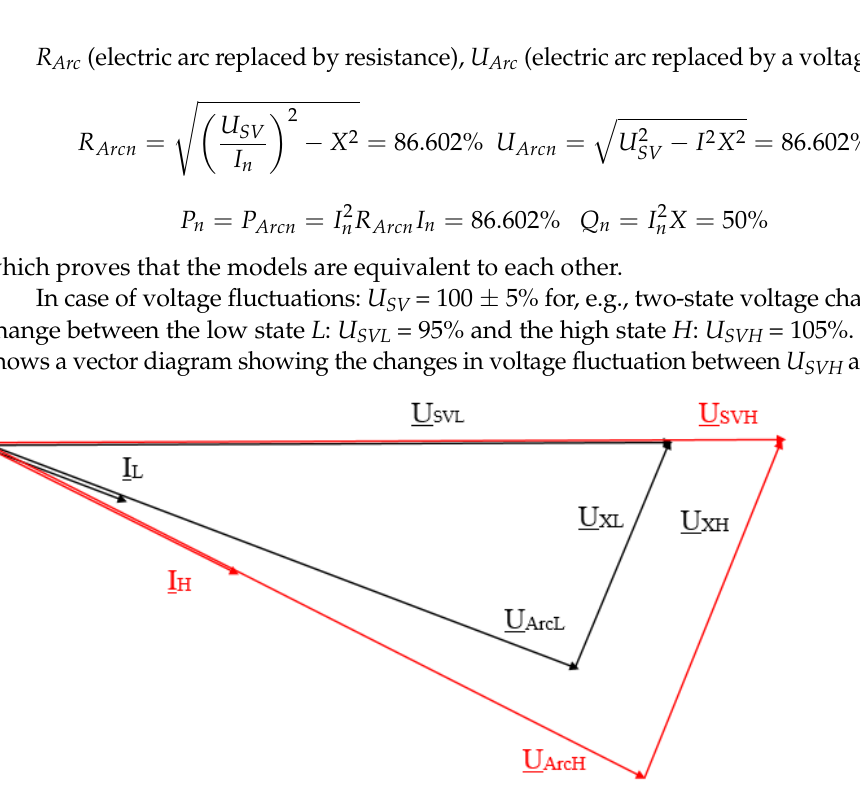
Figure 14. Vector diagram of the currents and voltages of the arc furnace.